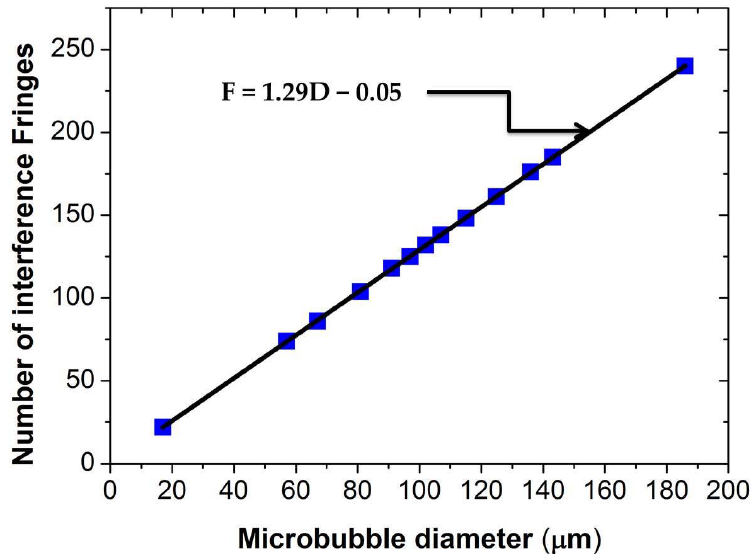
Figure 6. Relationship between the number of interference fringes and the bubble’s